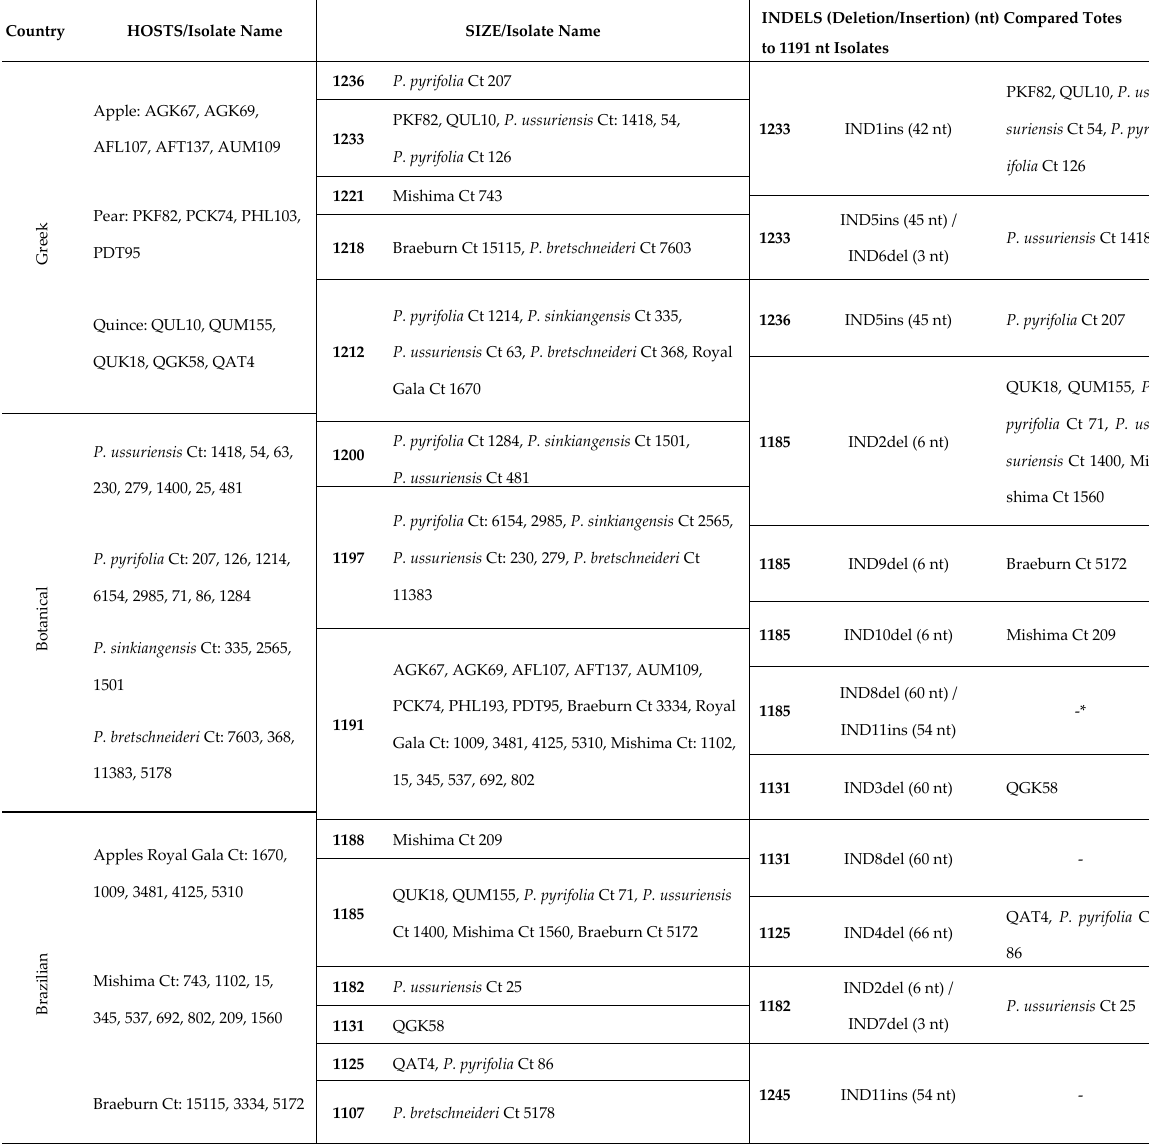
Table 1. List of isolates from Greece, Brazil and botanical species studied, according to their host type, size and presence of indels cited. * none of the isolates analyzed in the present study possess these indels.